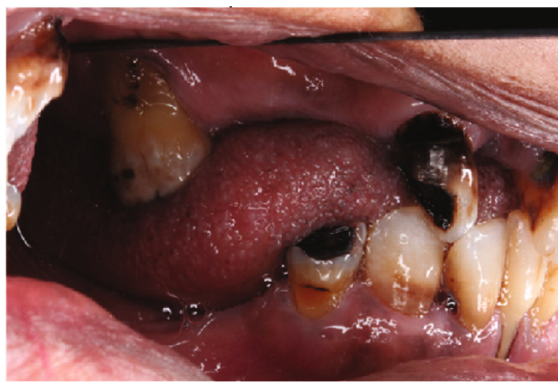
Figure 2: Preoperative right lateral view.